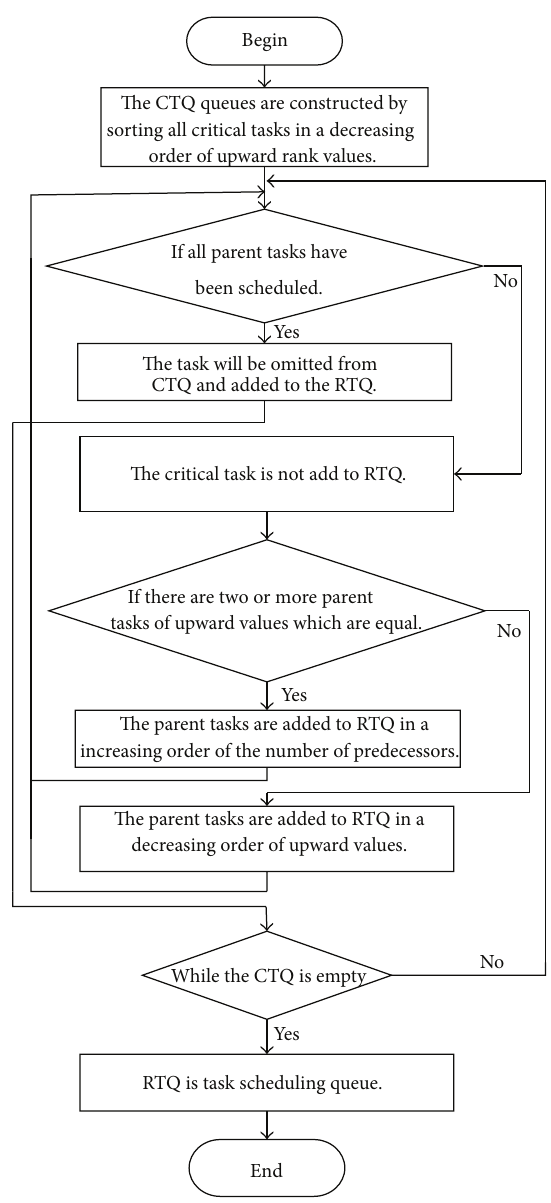
Figure 1: Constructing task scheduling